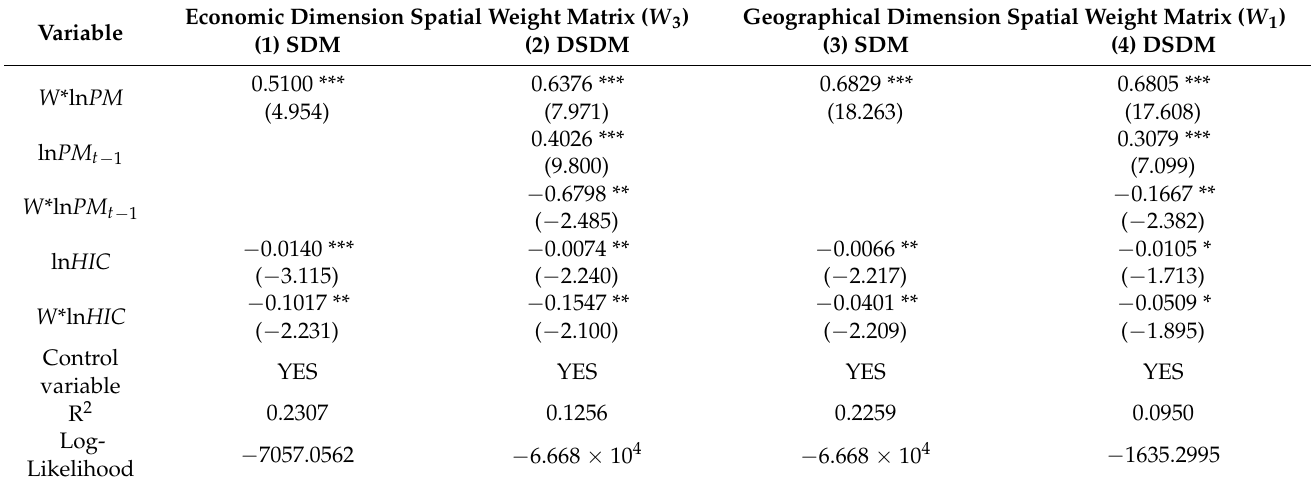
Table 9. Robustness test results of the impact of hydropower on haze pollution.